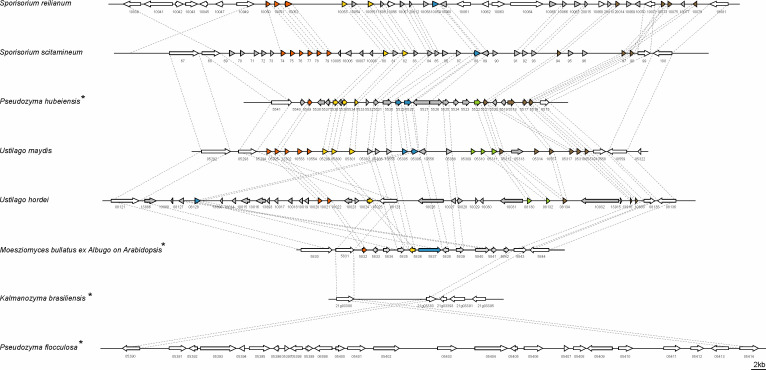
Structure of the largest virulence cluster (Cluster 19A) in pathogenic smut fungi and anamorphic smut yeasts (marked with*).Colors indicate genes with homology to each other: related gene families are indicated in orange, yellow, blue, green, and brown, whereas unique effector genes are shown in gray. Genes encoding proteins without a secretion signal are shown in white (Brefort et al., 2014).